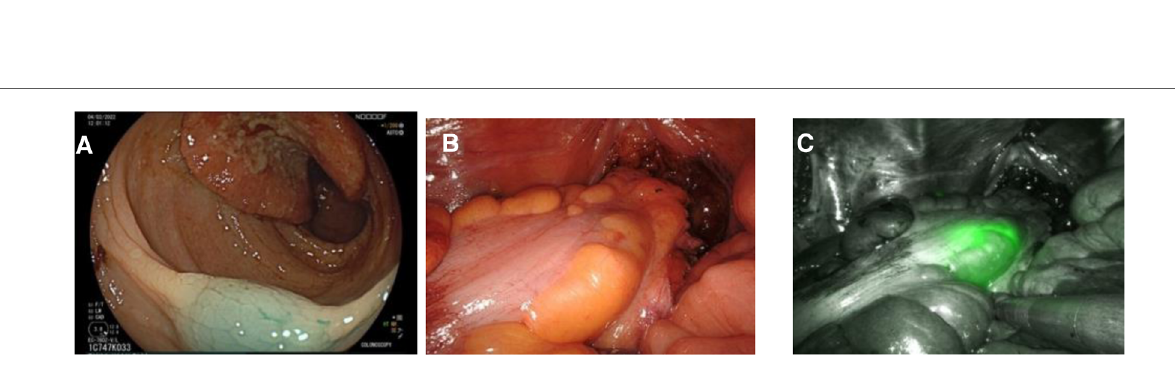
FIGURE 1 Endoscopic tattooing using indocyanine green in two patients. ( A ) Patient 1: Injection distally of tumor, one side. ( B ) Patient 1: Injection distally of tumor, other side. ( C ) Patient 2: Injection distally of tumor. ( D ) Patient 2: Injection distally of tumor.